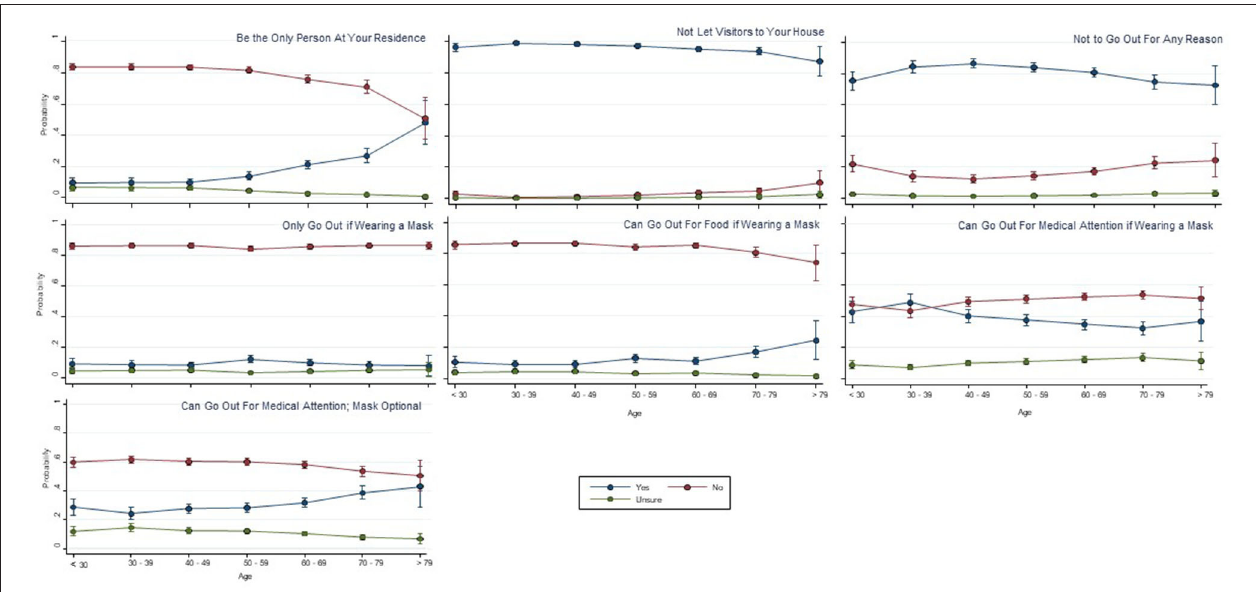
FIGURE 2 | Self-isolation means that you ... (probability of each response with 95%CI).